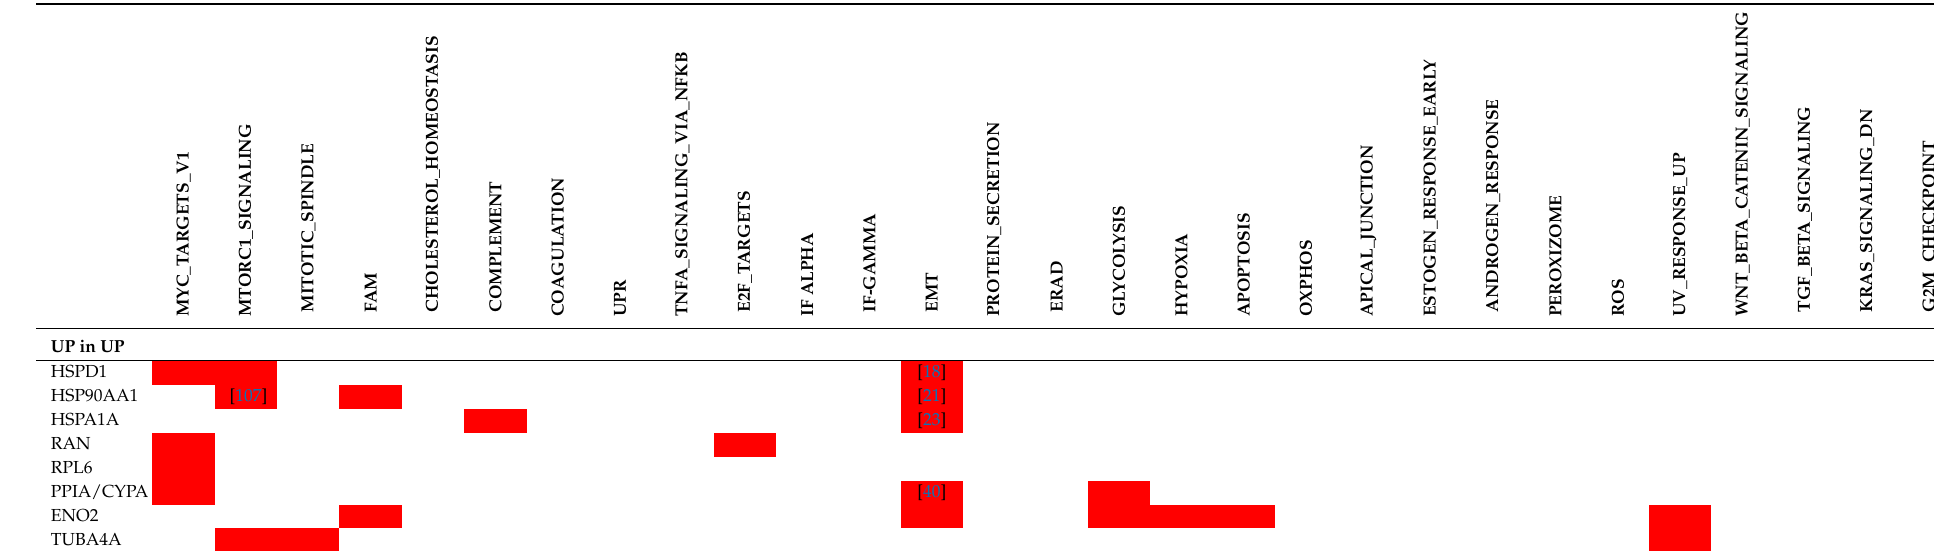
Table 4. Protumorigenic (in red) and antitumorigenic roles (in green) of JTB-related